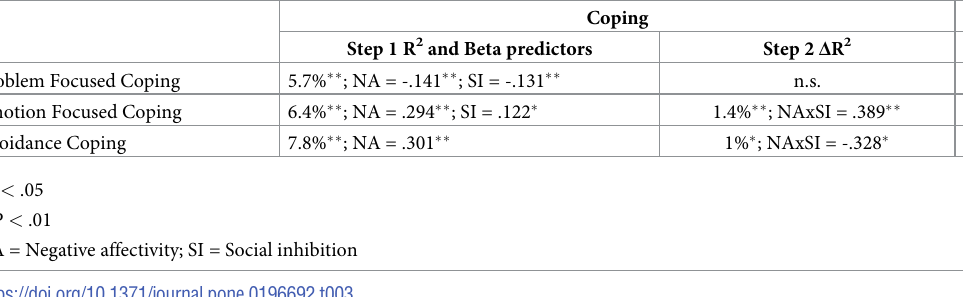
Table 3. Results of the regression analysis for Type D as a continuous variable (continuous